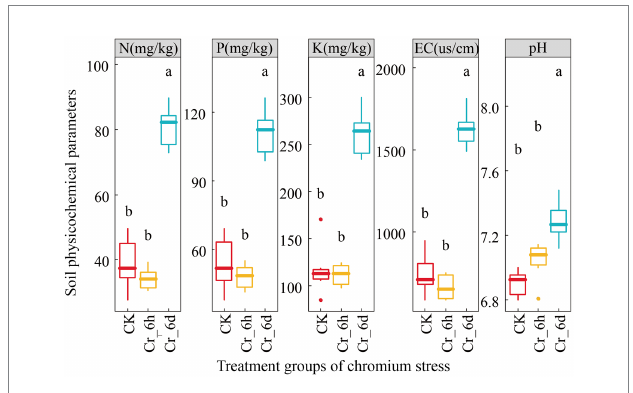
FIGURE 1 Variation trend of the soil physicochemical parameters in chromium- contaminated soils. CK, control treatment; Cr_6h, Cr stress for 6 h; Cr_6d, Cr stress for 6 days. Different letters indicate significant differences among treatments at the p < 0.05 level. The upper, middle, and lower lines of the box chart represent the upper quartile, median, and lower quartile, respectively, and the vertical line is the error bar.